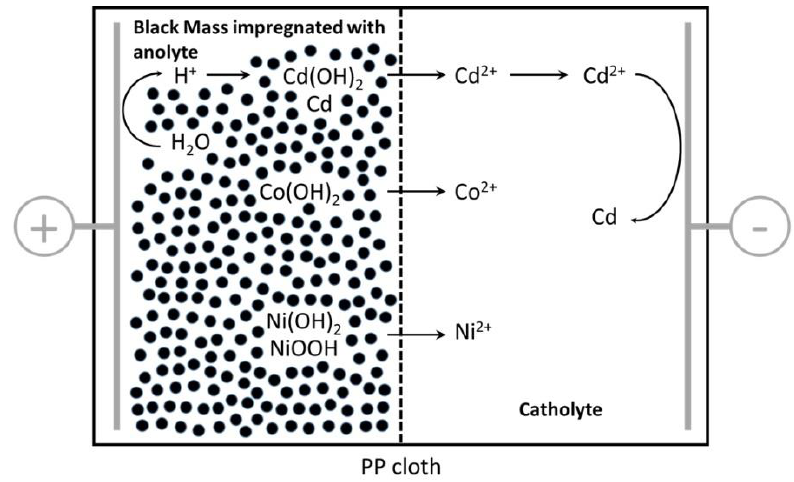
Figure 4. Cell configuration for electroleaching/electrodeposition applied to Ni/Cd Black Mass.